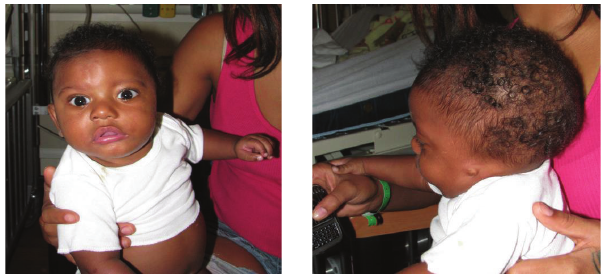
Figure 1: Patient with GS at 8 months of life with features of left hemifacial microsomia and left anotia.